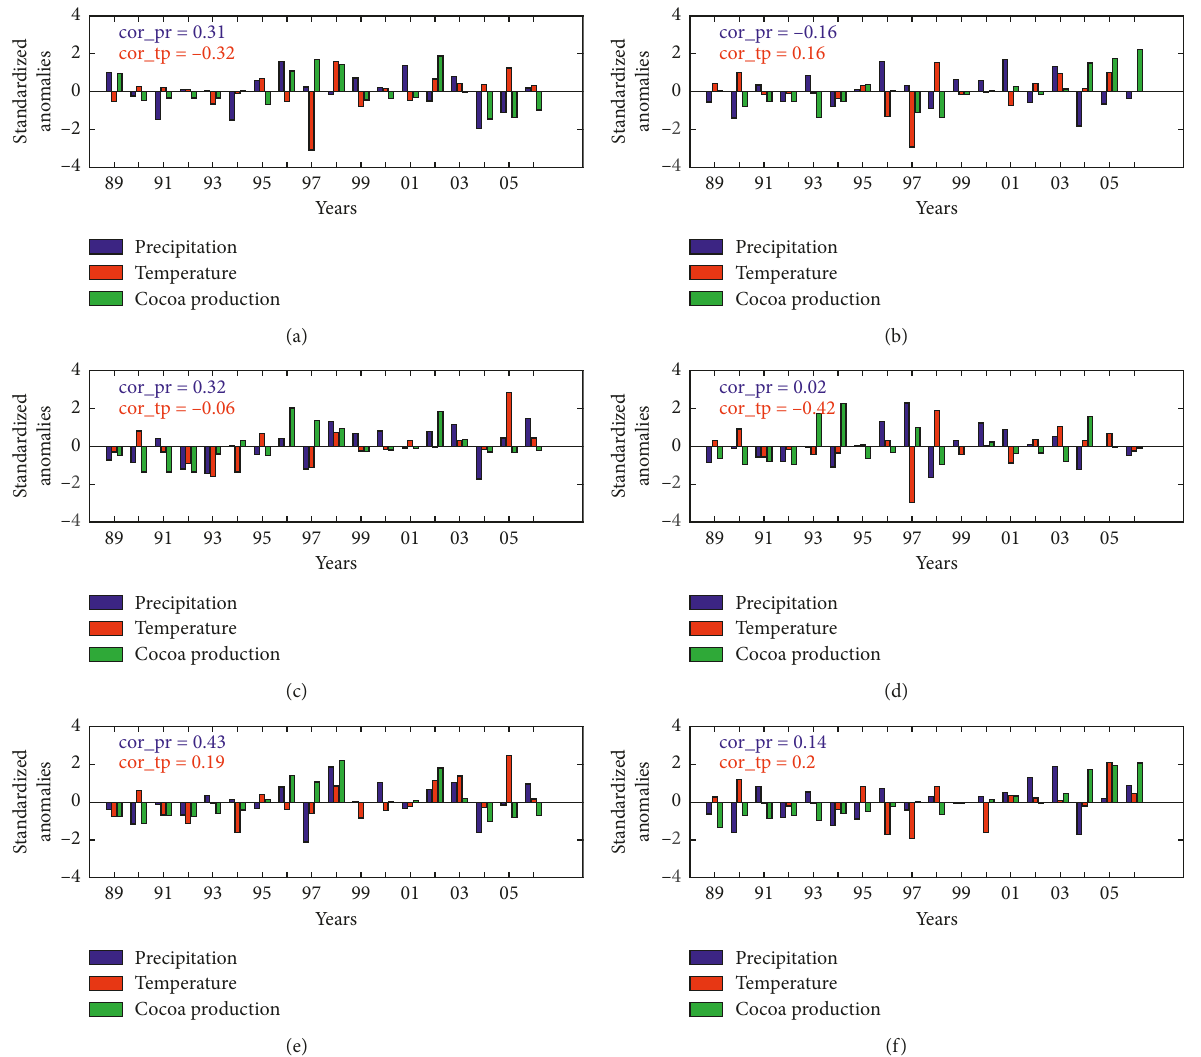
Figure 4: Standardized anomalies of rainfall of the main rainy season, temperature, and cocoa production in the six departments from 1989 to 2006. The correlation coefficients between cocoa production and rainfall (blue) and temperature (red). (a) Abengourou. (b) Agboville. (c) Daloa. (d) Dimbokro. (e) Guiglo. (f)